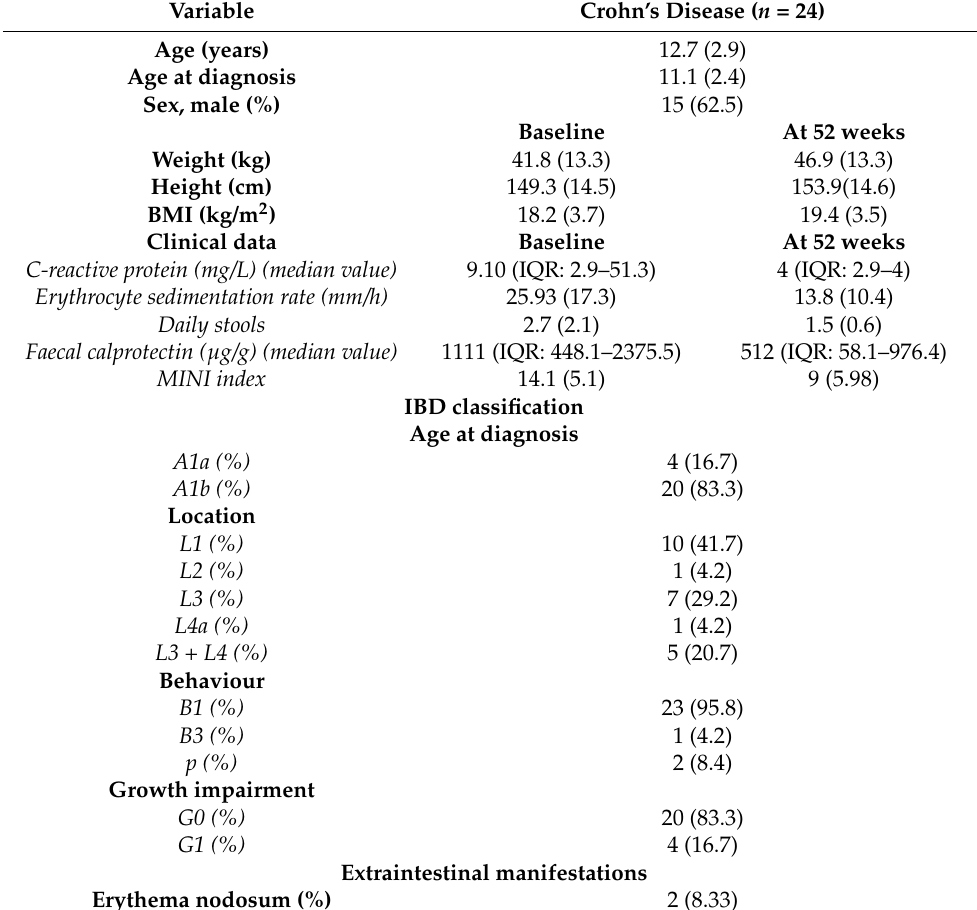
Table 1. Clinical characteristics of the patients included in the